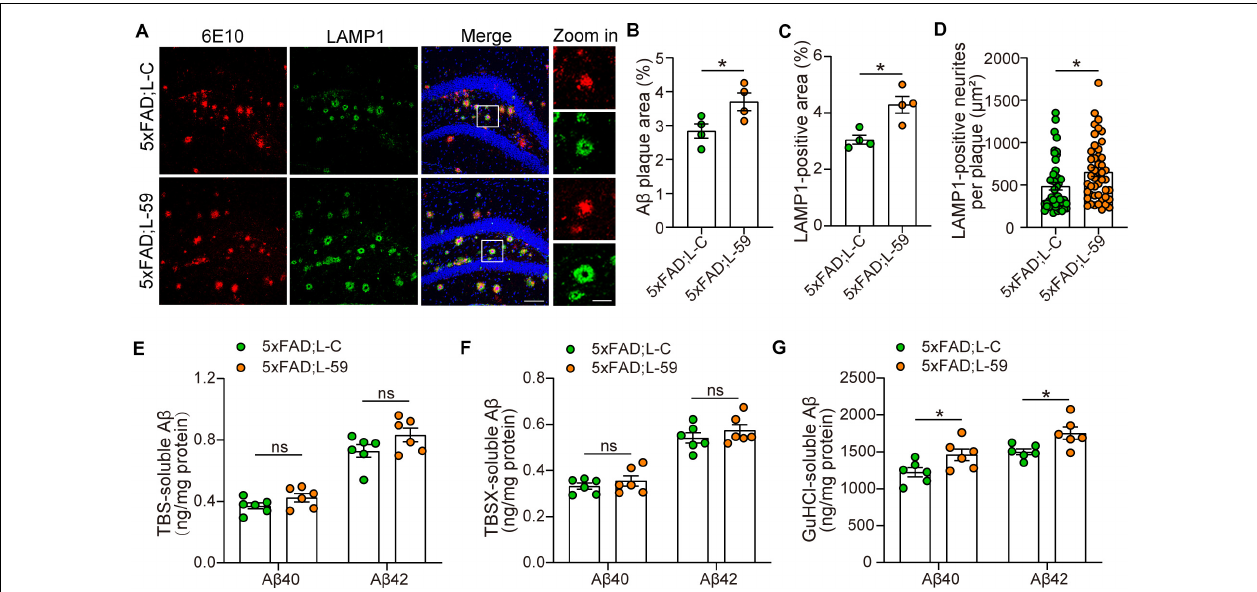
FIGURE 2 | Overexpression of TMEM59 exacerbates A β plaque deposition and neurite dystrophy in 5xFAD mice. (A) Z-stack confocal images of A β plaques (in red) and dystrophic neurites (indicated by LAMP1, in green) in the coronal sections from 6 to 7 month-old 5xFAD; L-C and 5xFAD; L-59 mice. Original magnifications are 20 × , scale bar, 100 µ m. Zoom-in images are on the right, scale bar, 30 µ m. (B,C) Quantifications and comparisons of the total area of A β plaques (B) and LAMP1-positive dystrophic neurites (C) shown in (A) . n = 4 mice per group. (D) Quantifications and comparisons of the area of A β -associated LAMP1-positive dystrophic neurites per plaque shown in (A) . 48 plaques from four 5xFAD; L-C mice and 47 plaques from four 5xFAD; L-59 mice were studied for analysis. (E–G) The levels of A β 40 and A β 42 in the hippocampus of TBS-extractions (E) , TBSX-extractions (F) , and GuHCl-extractions (G) from 8 month-old 5xFAD; L-C and 5xFAD; L-59 mice were measured by ELISA and compared. n = 6 mice per group. Data represent mean ± SEM. * p < 0.05, ns: not significant. Unpaired t -test.